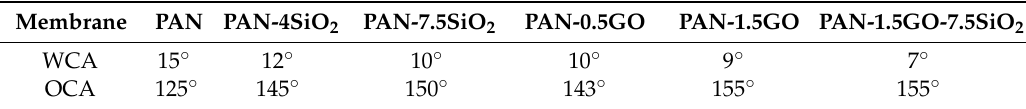
Table 3. Water contact angle (WCA) and underwater oil contact angle (OCA) for developed membranes.